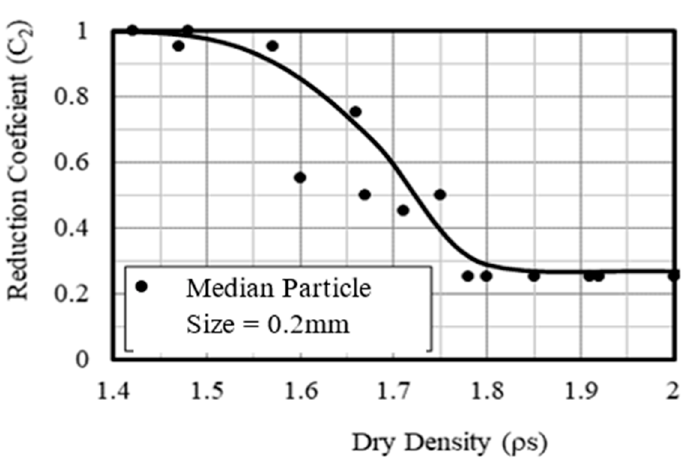
Figure 5. Influence of dry density to the bed-load reduction coefficient (the median grain size and the uniformity coefficient are 0.2 mm and 20.1 mm, respectively).